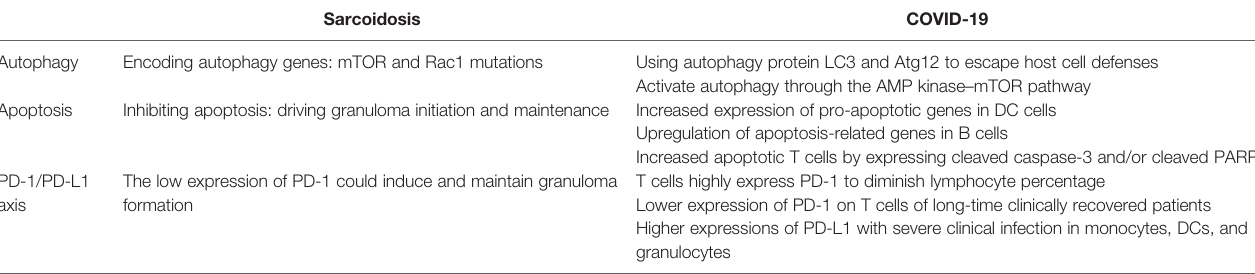
TABLE 2 | The features of sarcoidosis and COVID-19 on cell death pathways.